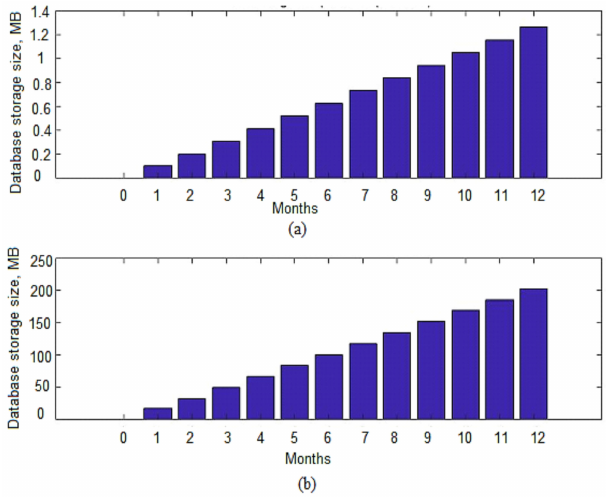
Figure 10. Data storage per metric ( a ) Best-case ( b ) Worst-case.